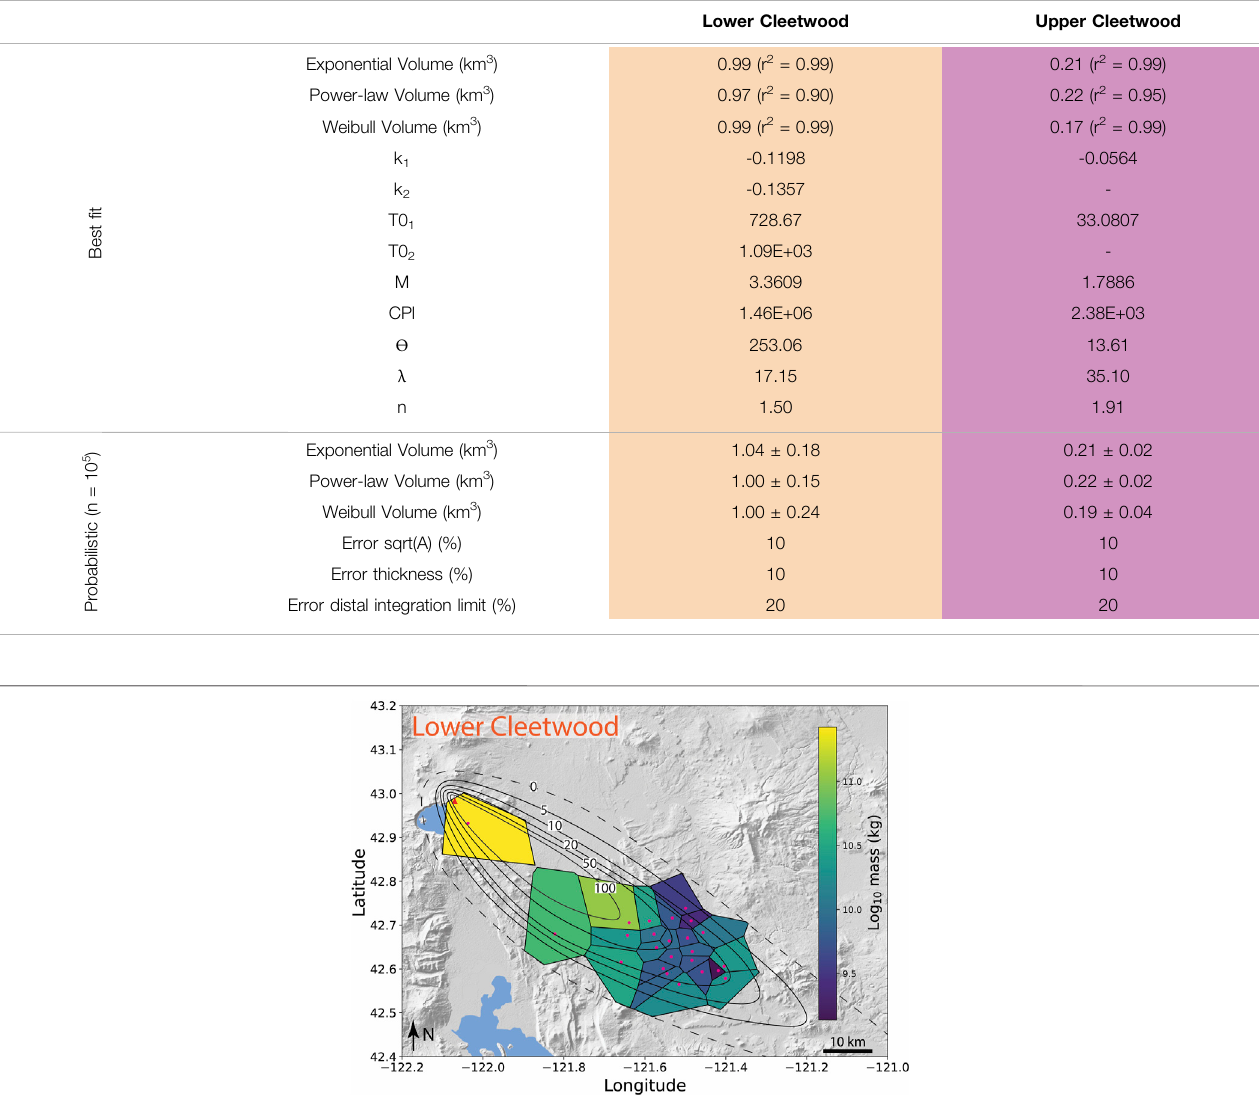
Lower Cleetwood Upper Cleetwood